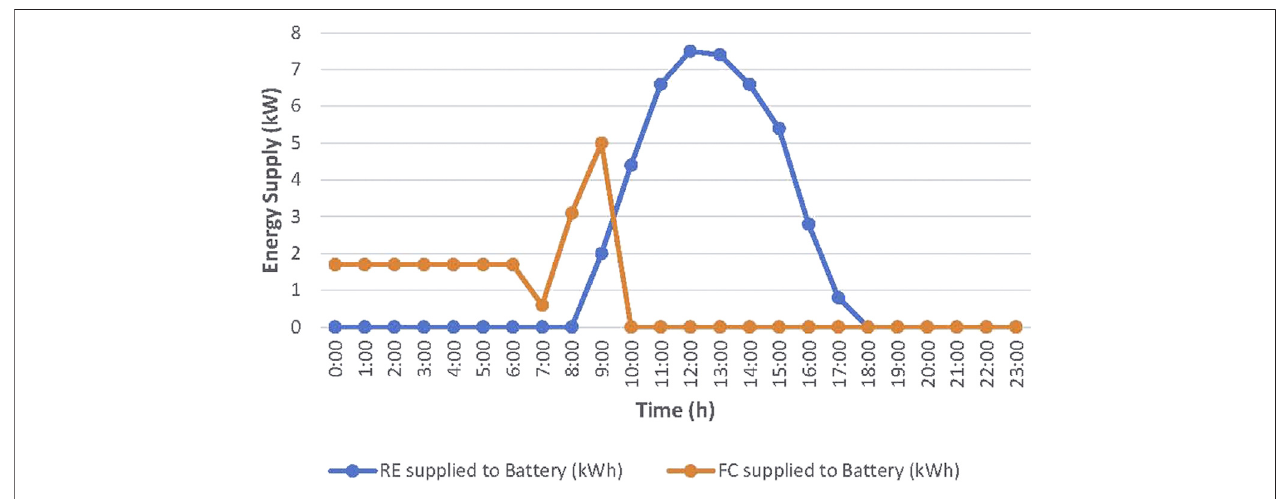
Figure 10 : 6:00 h – 7:00 h), and the IPMS assigned the fuel cell